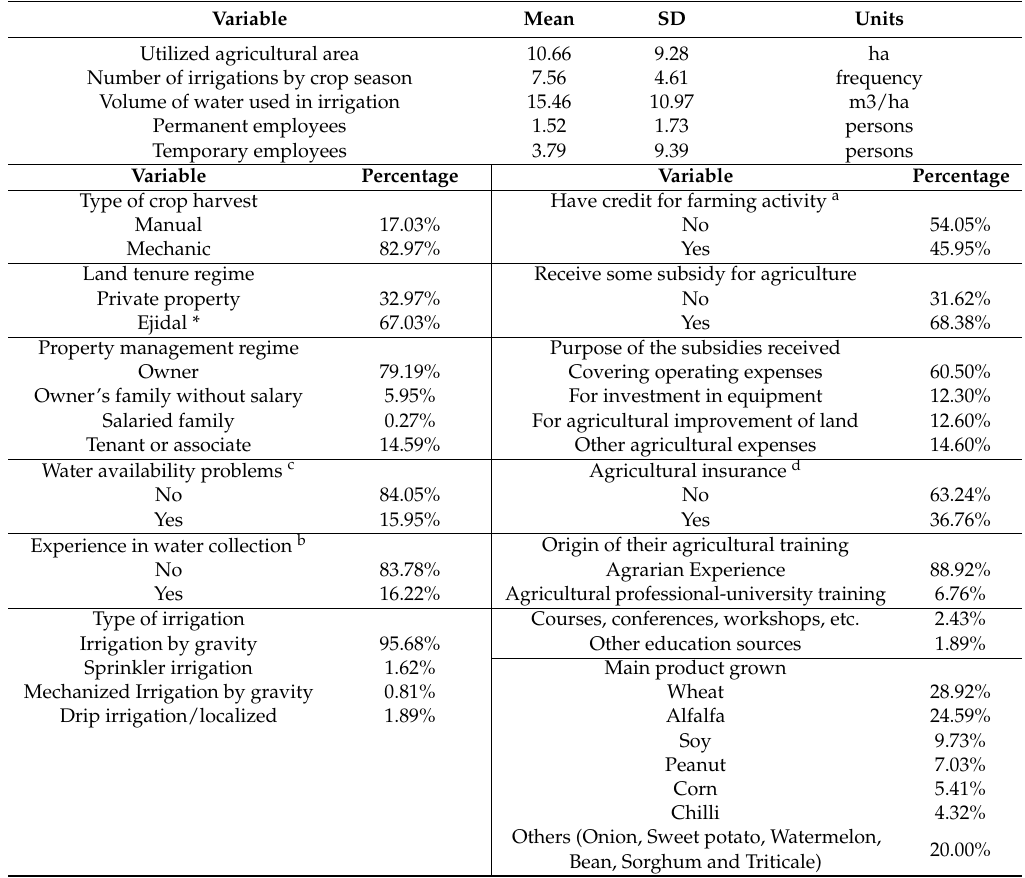
Table 2. The description of the farms and main crop